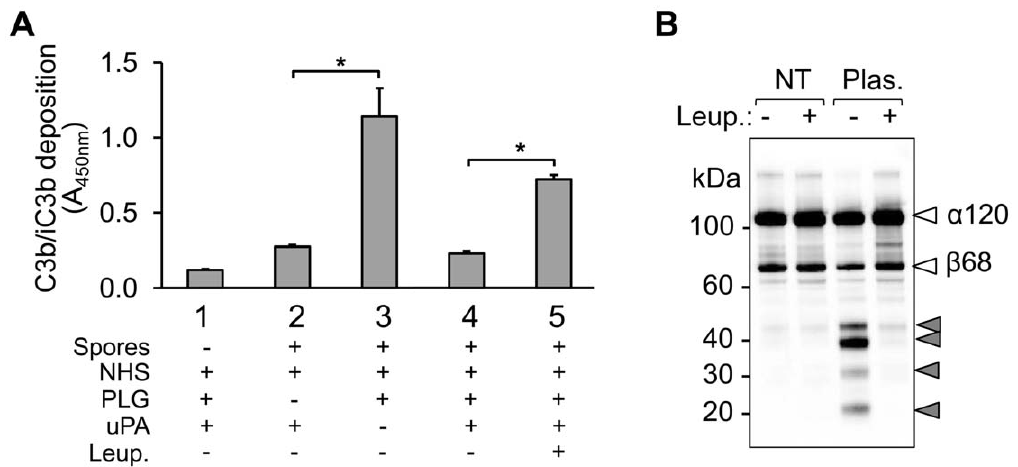
Figure 6. Degradation of deposited C3b by B.anthracis spores-bound PLG. (A) Spores (2 6 10 7 /well) were immobilized onto a microplate and incubated with 10% NHS (100 m l) for 30 min at room temperature. Washed spores were incubated with 2 m g/well PLG for 1 h in the presence or absence of protease cocktail. Bound PLG was activated by uPA (20 units/well) for 3 h at 37 u C. Deposited C3b was detected by anti-C3c IgG and HRP- conjugated secondary antibody followed by TMB reaction. C3b deposition is expressed as the mean absorbance at 450 nm of quadruplicates. Error bars indicate 6 standard deviation. *P , 0.001 (paired Student’s t-test). (B) Spores were incubated with plasmin and washed extensively as described in Figure 2A. C3b was incubated with the spores in the presence or the absence of leupeptin and C3b degradation was analyzed by Western blot with